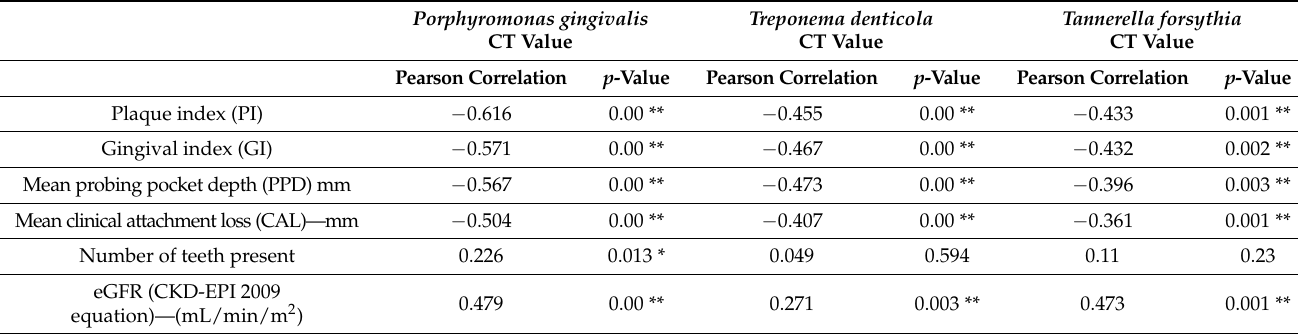
Table 8. Overall Pearson’s correlation of red-complex bacteria (RCB) with periodontal and renal